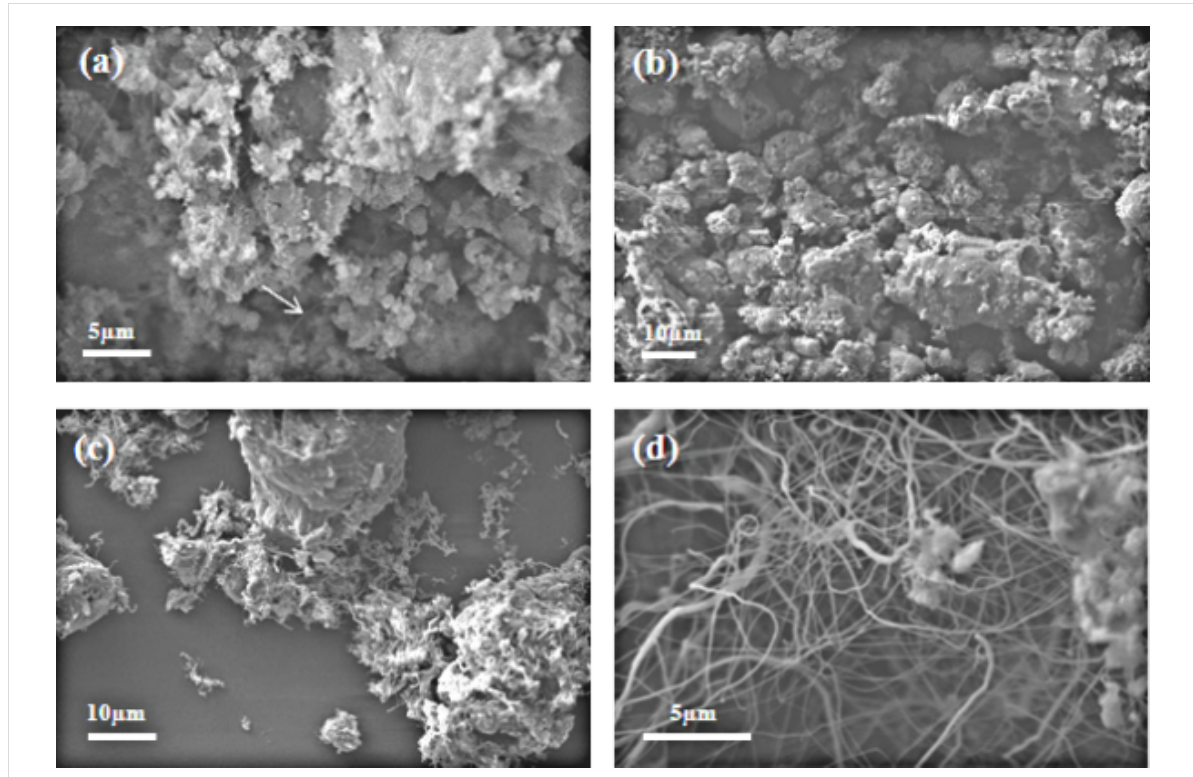
Figure 1: SEM images showing the influence of catalyst on synthesis of BNNTs. (a) No catalyst, (b) Al 2 O 3 , (c) Fe 3 O 4 , and (d) Fe 2 O 3 .